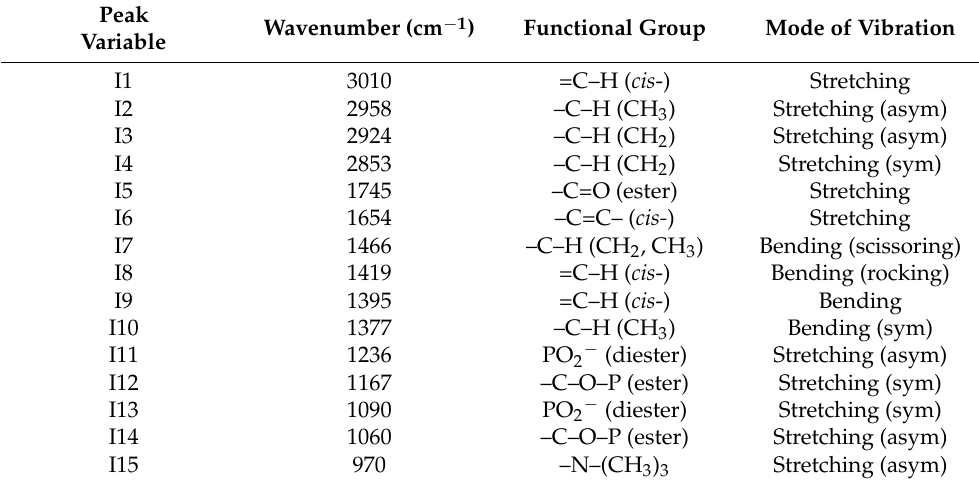
Table 1. Assignment of absorption signals in FT-IR spectrum of krill oil reference sample [1,36,37].